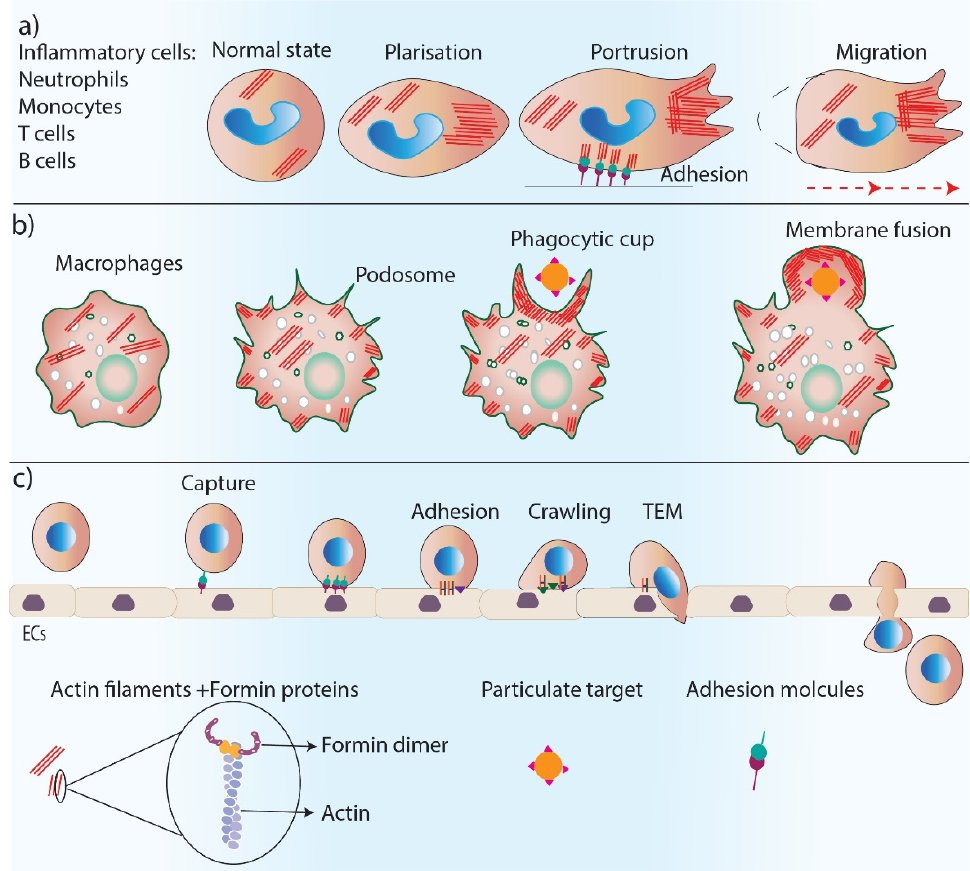
Figure 3. Formins’ role in inflammation. Formins play an essential role in inflammation by regulating actin polymerization in inflammatory cells. ( a ) Formins control cell polarity, cell protrusions and directed migration in inflammatory cells. ( b ) Formins are involved in podosome and phagocytic cup formation and the phagocytosis process. ( c ) Trans-endothelial migration of inflammatory cells requires several steps including, cell capture, adhesion, crawling and TEM which are all regulated by formin-mediated actin polymerization.